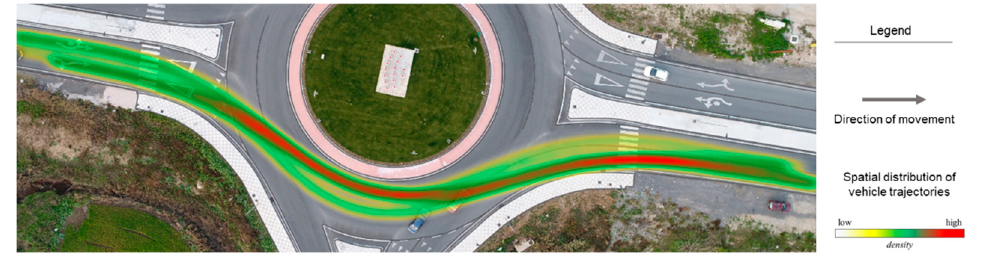
Figure 7. Heatmap of the spatial distribution of vehicle maneuvers of Roundabout A. To calculate vehicle speeds at the entrance of the roundabout, firstly the proper events were identified. Then, the captured distances per 0.2 s were calculated and divided by the corresponding time. Considering the measured value of the ground sample distance (35.6 mm) and the RMS error of 0.6, it is concluded that the maximum error in speed estimation is less than 1 km/h. An indicative calculated speed profile of a vehicle traversing the roundabout is presented in Figure 8.